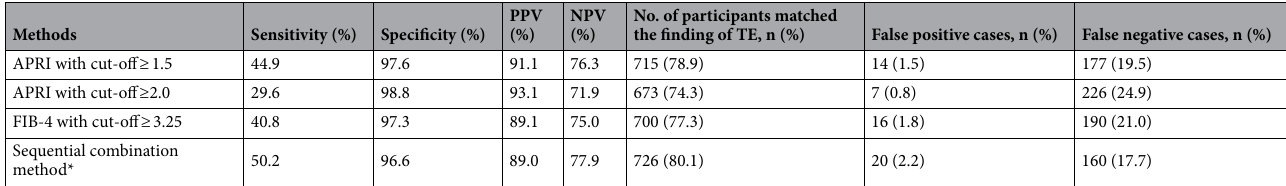
Table 3. Diagnostic performances of APRI, FIB-4 and the sequential combination method for liver cirrhosis among people living with hepatitis C. TE transient elastography, PPV positive predictive value, NPV negative predictive value, APRI aspartate-to-platelet ratio index, FIB-4 fibrosis 4 index. *For patients with APRI score between > 1.0 and < 1.5, liver cirrhosis was predicted by further assessment using FIB-4